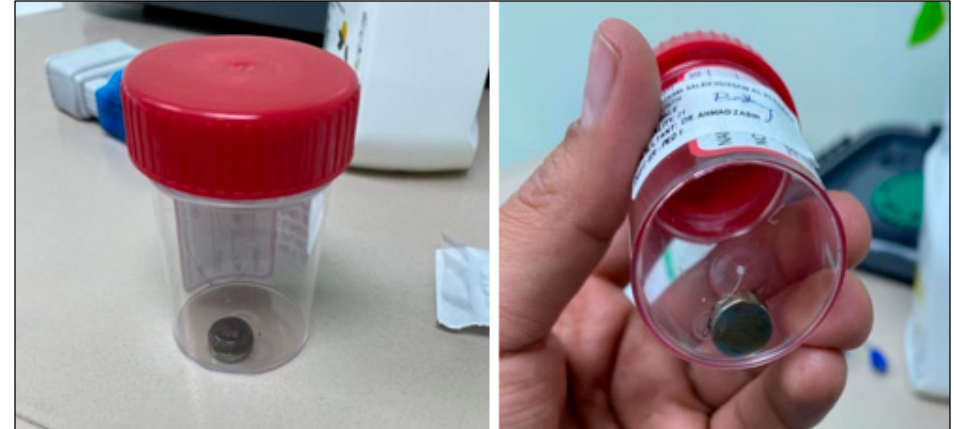
Figure 2. Foreign body (Button battery Silver-oxide type) immediately after removal.